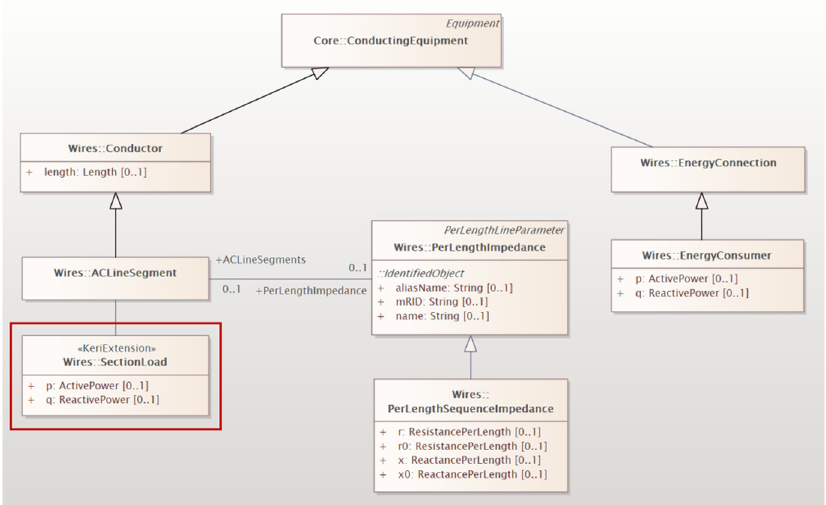
Figure 8. An example of gap